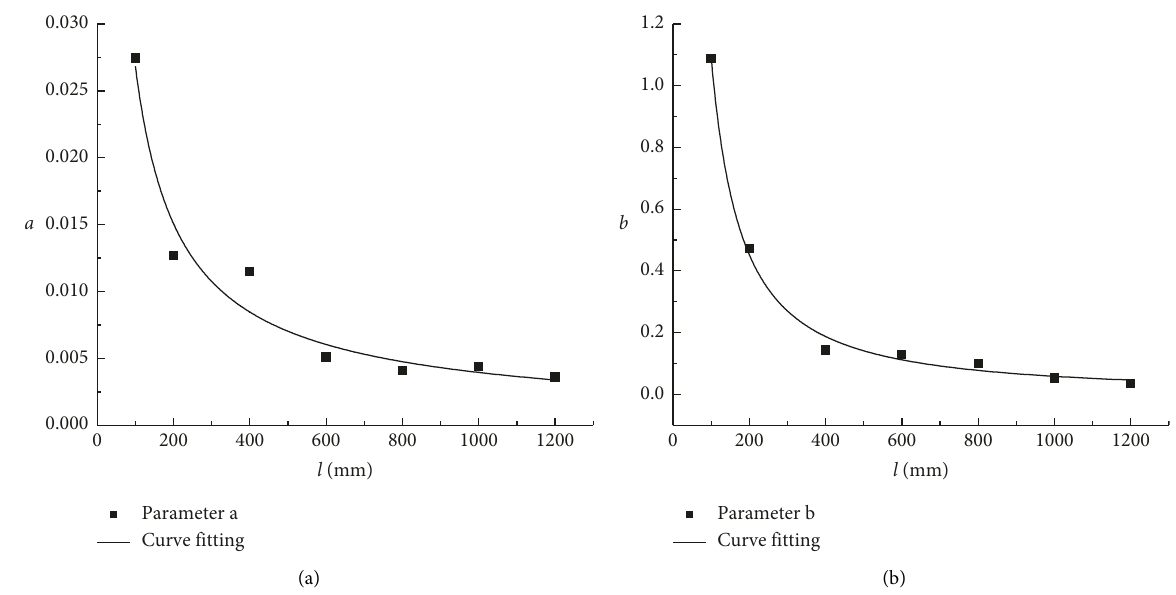
Figure 4: Fitting curve diagrams. (a) Parameter a ; (b) parameter b .